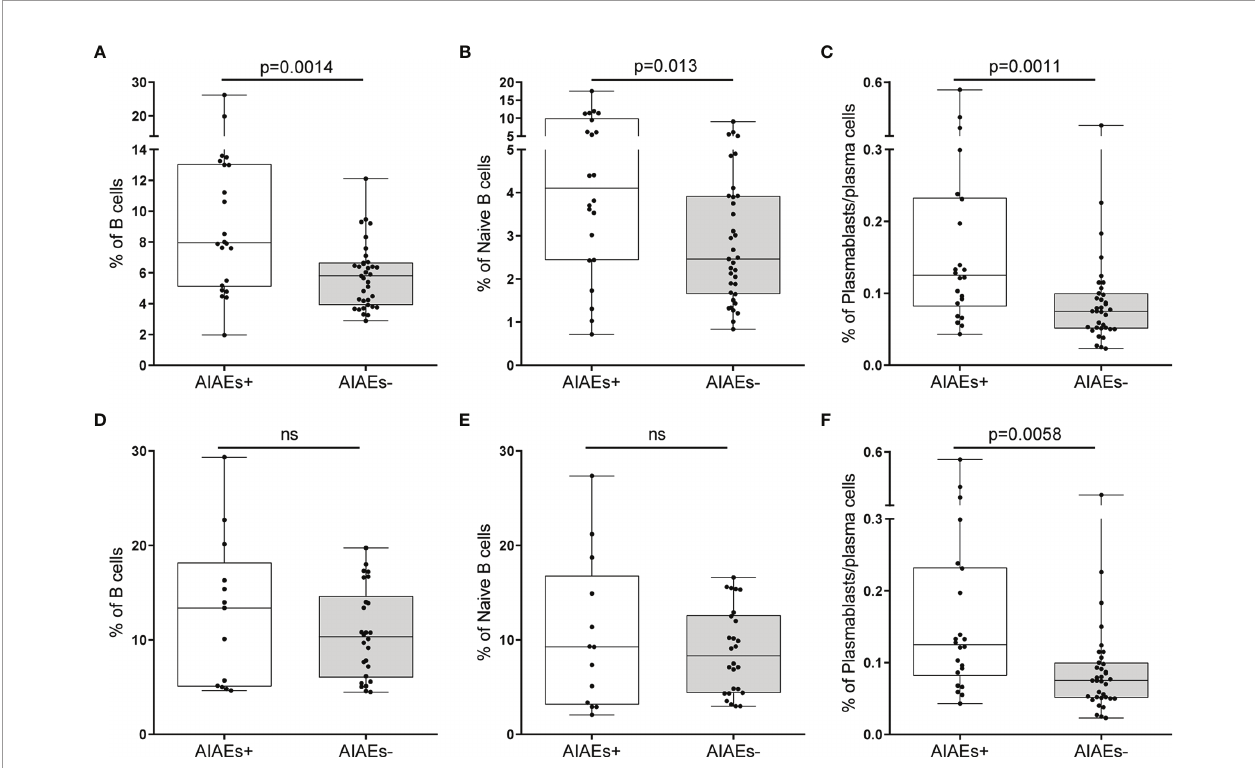
FIGURE 2 | Percentages of cell subsets classi fi ed according to the presence or absence of adverse autoimmune events (AIAEs). Percentages of total B cells (A, D) , naïve B cells (B, E) and plasmablasts (C, F) at baseline (A – C) and at 12 months of alemtuzumab treatment onset (D – F) in 22 patients who developed AIAEs (+) and 35 who did not (-). All percentages are relative to total peripheral blood mononuclear cells. Median values and 25%-75% interquartile range are shown in plots. p- value were obtained using Mann – Whitney U test. ns, not signi fi